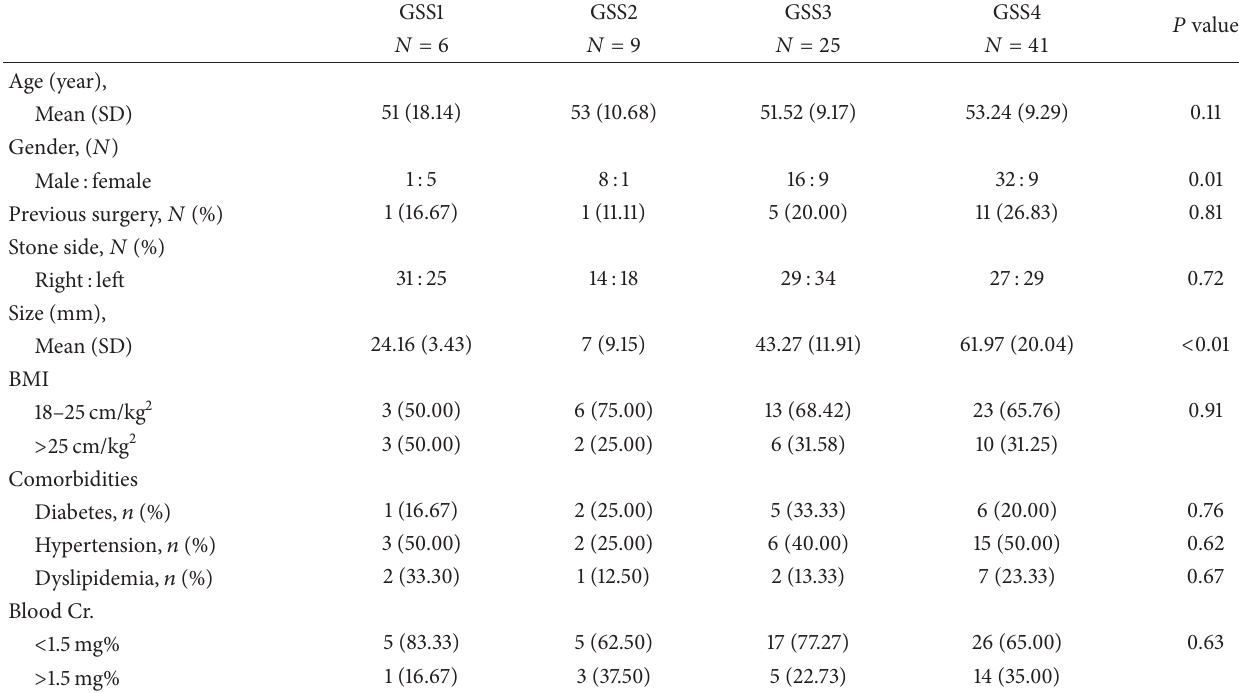
Table 3: The demographic data of supracostal upper access patients ( 𝑁 = 81 ).